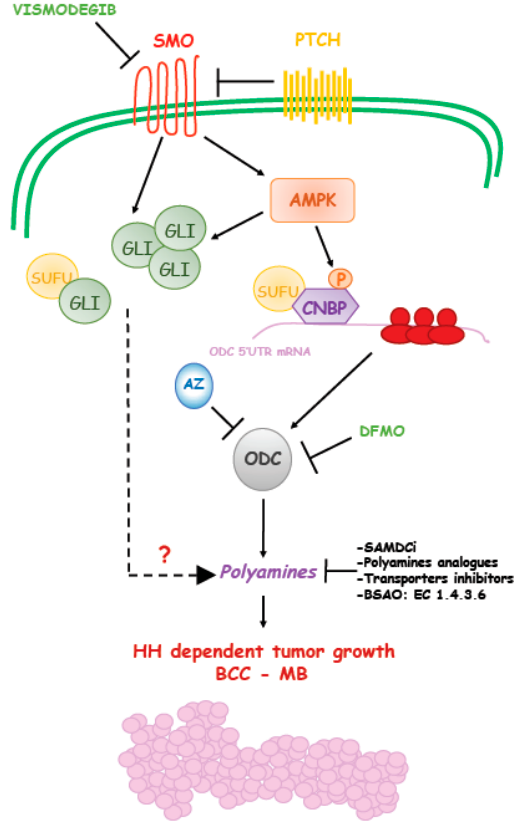
Figure 2. Schematic representation of Hedgehog-induced polyamines production during cancer formation. Hedgehog signaling induces polyamines levels through upregulation of ODC translation.